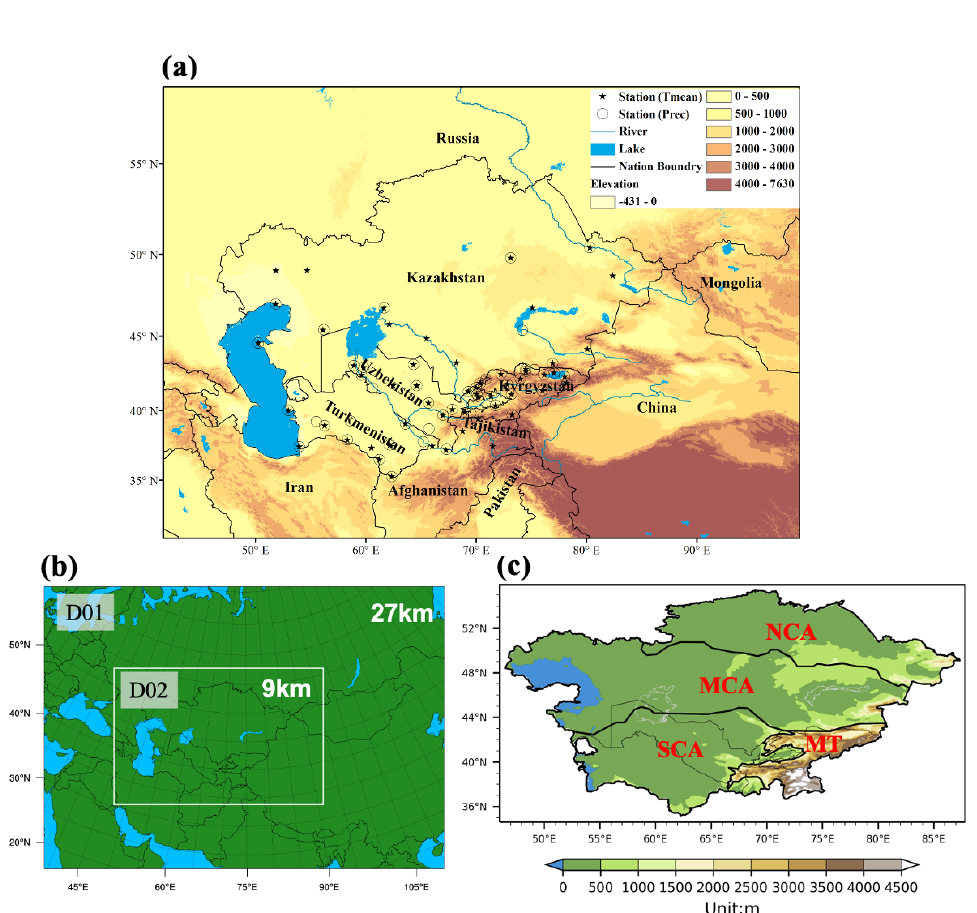
Figure 1. Central Asia (referred to as CA) and its surroundings (a) , nested domains in the WRF model (b) , and climate subregions in CA (c) . In (a) , stations with records of daily mean temperature and precipitation are marked by stars and circles, respectively. In (c) , according to Qiu et al. (2021), the CA region is divided into four climate sub-regions: northern CA (NCA), middle CA (MCA), southern CA (SCA), and the mountainous areas